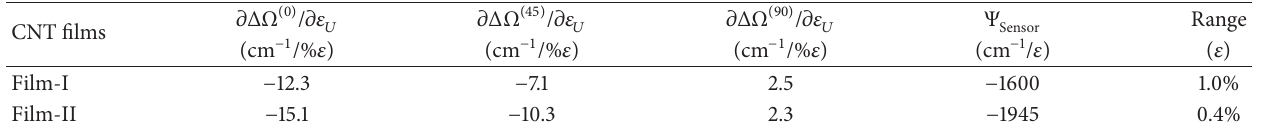
Figure 7: The experiment on the fiber-reinforced bar under four-point bend loading. (a) The geometrical shape, dimensions, and loading near the vicinity of the slop tip achieved by the CNT strain sensor. type, (b) Raman mapping region, (c) the distribution of 𝛾 xy Table 1: Strain-sensing properties of CNT films prepared by different